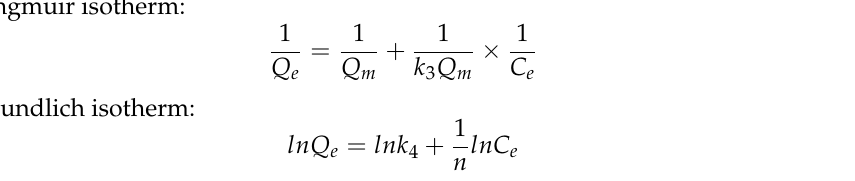
Table 2. Parameters of Langmuir adsorption model and Freundlich adsorption model.